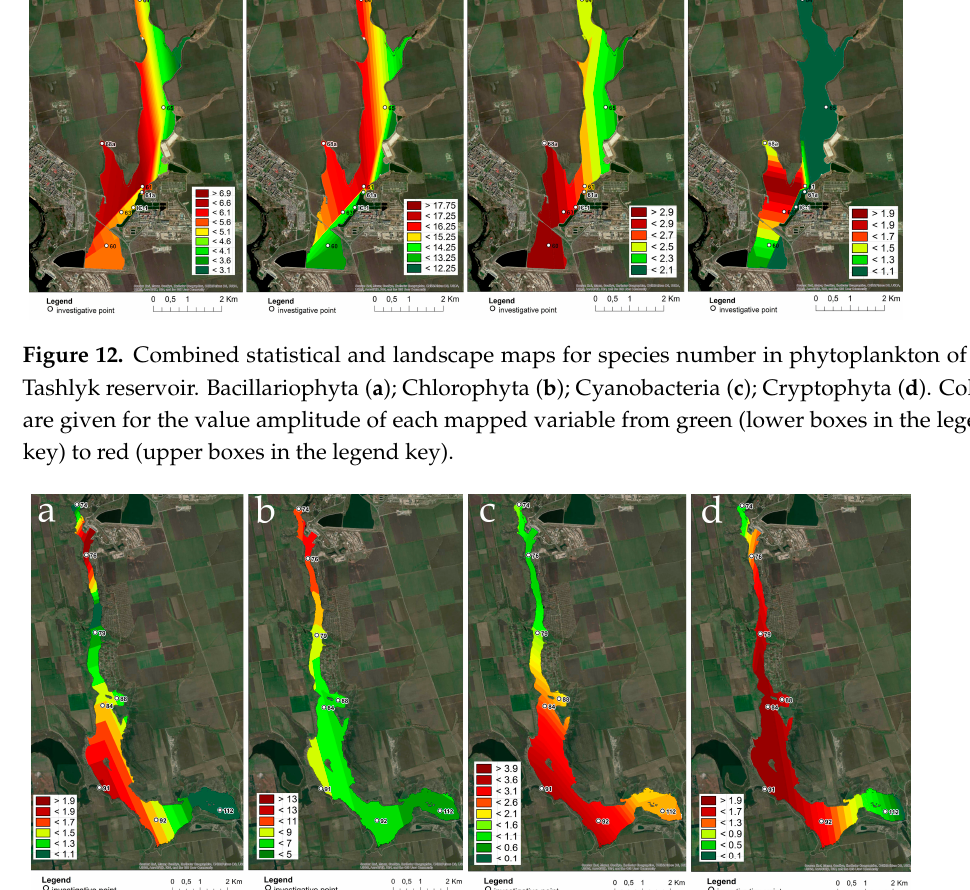
Figure 13. Combined statistical and landscape maps for species number in phytoplankton of the Alexandrovskoye reservoir. Bacillariophyta ( a ); Chlorophyta ( b ); Cyanobacteria ( c ); Cryptophyta ( d ). Colors are given for the value amplitude of each mapped variable from green (lower boxes in the legend key) to red (upper boxes in the legend key).